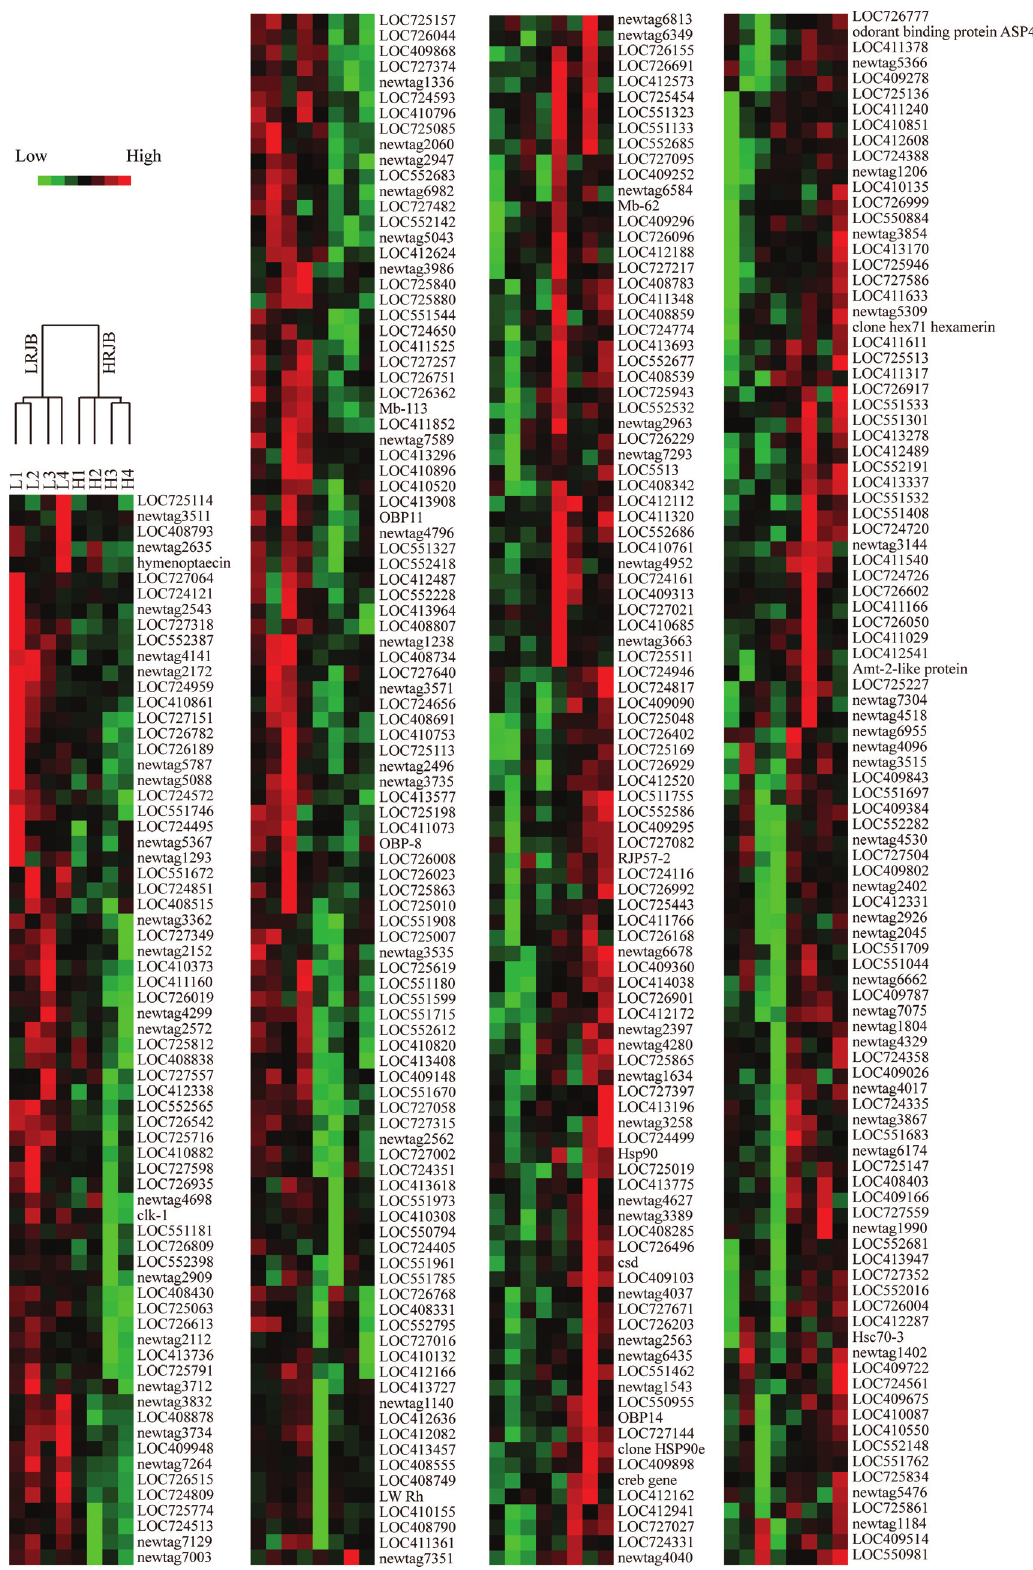
Figure 2 - Hierachical clustering analysis of 369 differently expressed genes. Each horizontal row indicates a gene, and each vertical column represents a colony. In the top of the figure, the tree diagram represents the eight colony samples, which are divided into two groups: high royal jelly producing bees (HRJB) and low royal jelly producing bees (LRJB). Red represents up-regulated genes in HRJB; green represents down-regulated genes in HRJB. Light shades reflect different levels of up- or down-regulated